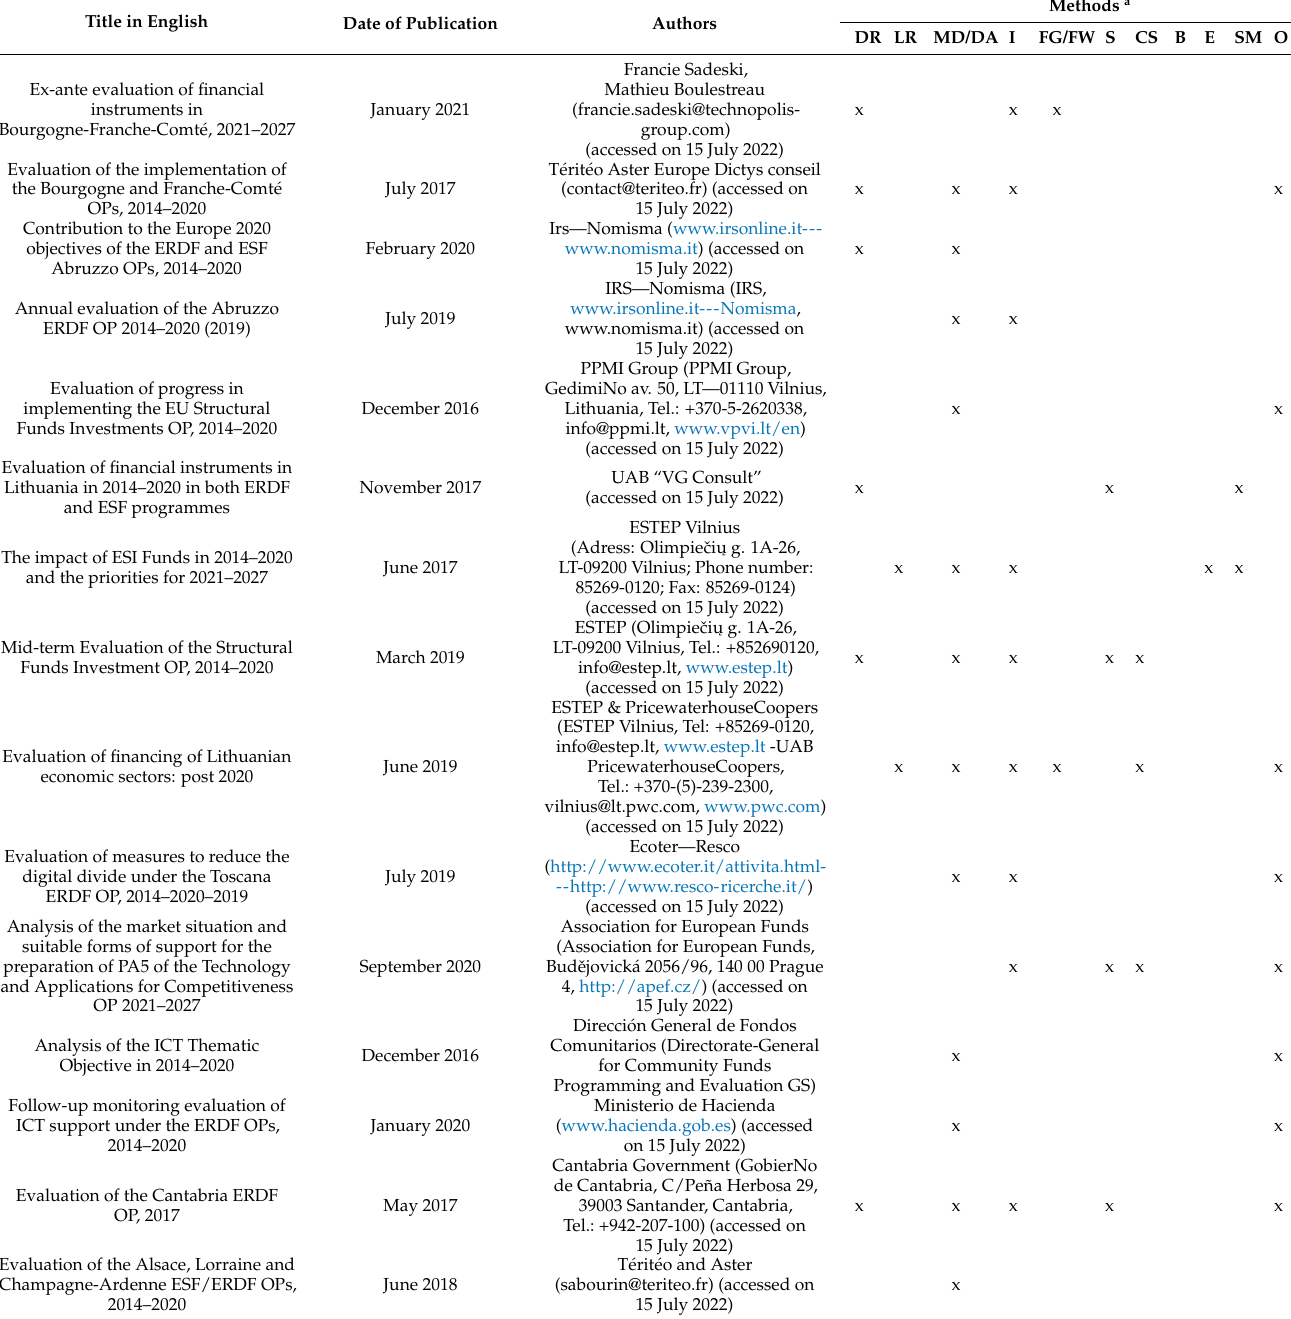
Table A1. List of Cohesion Policy OPs’ evaluations mentioning ICT and SMEs from 2015 to